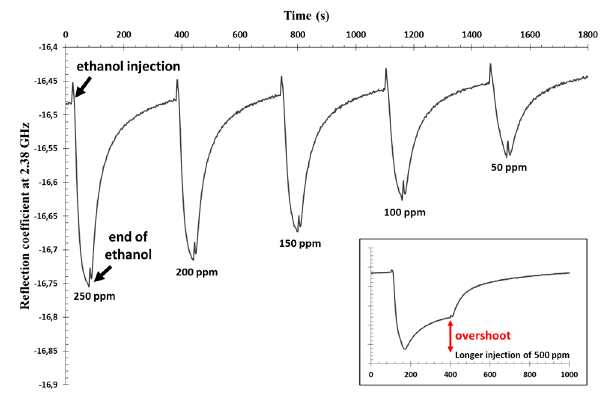
Figure 2. Evolution of the reflection coefficient at 2.38 GHz for 1 min exposures of diluted ammonia (50 to 250 ppm) and 5 min of pure argon. The inset shows the evolution for a 5 min exposure at 500 ppm of